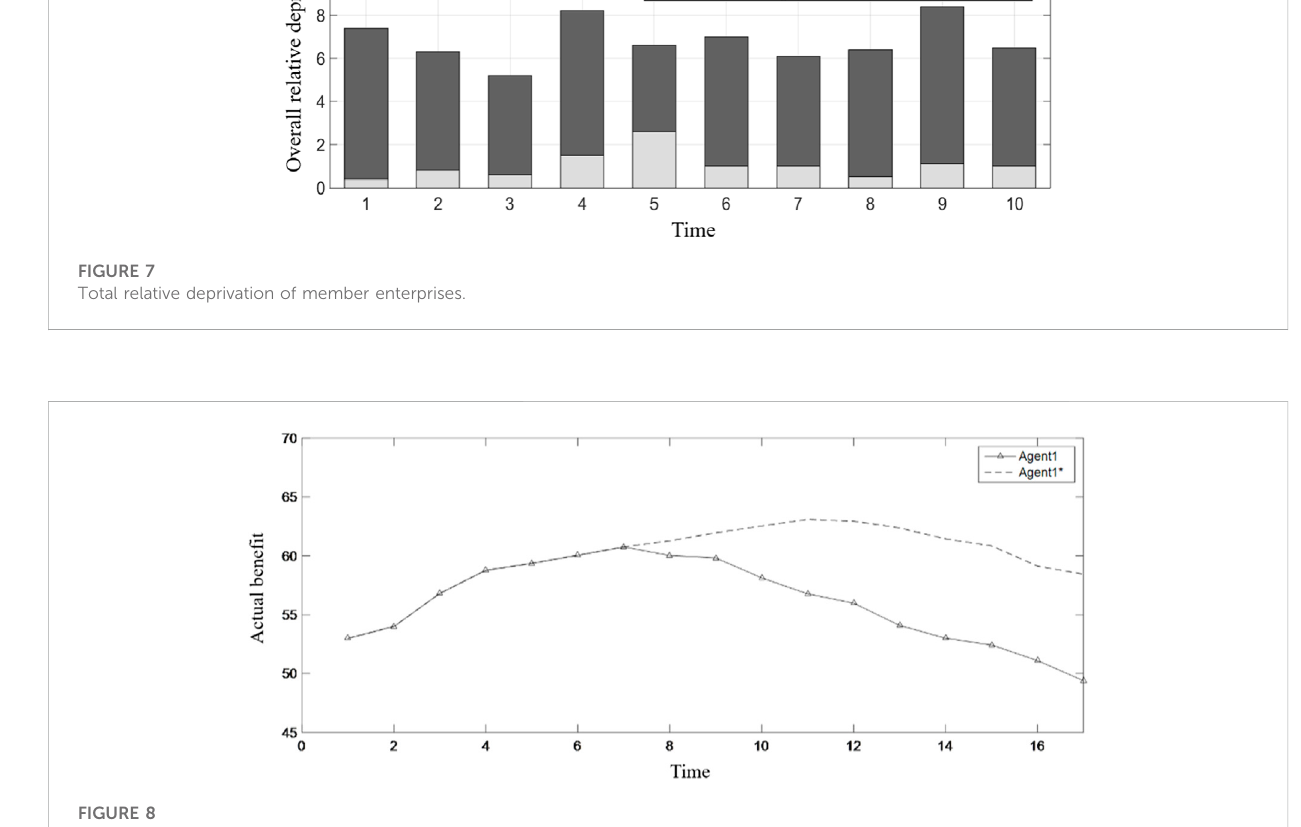
is getting smaller. The return of Agent 1 at the fi rst time increase to the maximum point is 60.76, and the return at the last time increase to the maximum point is 46.79, indicating that with the increase in the number of games, the incentive for Agent 1 to increase the return